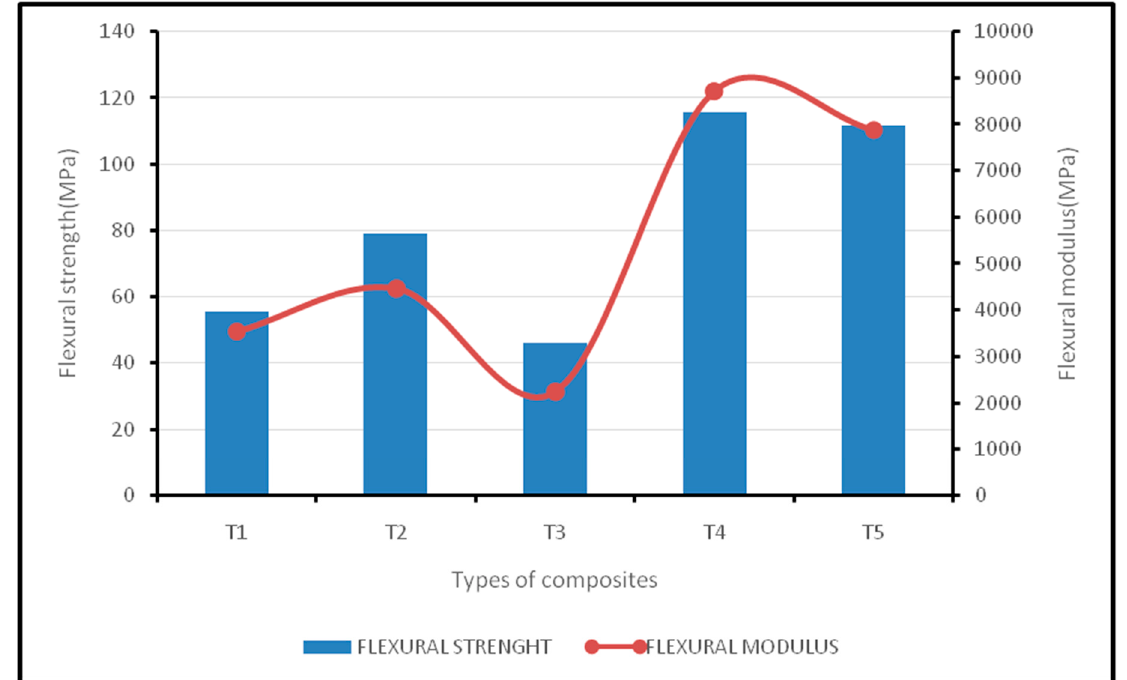
Figure 3. Flexural strength and modulus of oil palm EFB/kenaf woven fiber-reinforced epoxy-based bi-layer composites.